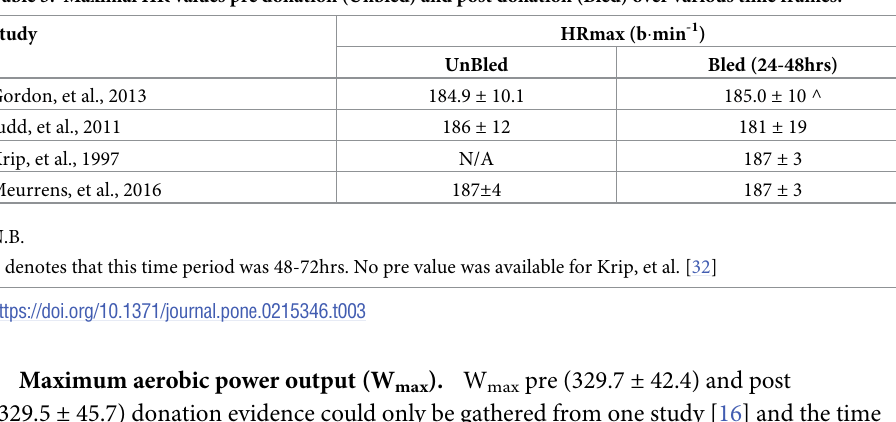
Fig 2. Statistical results from four studies of pre and 24–48 hr post BD in _ VO the effect size of the studies. The white diamond shows the overall mean effect size. All effect sizes are Cohen’s d and 95% confidence interval, with heterogeneity of I 2 = 0%. https://doi.org/10.1371/journal.pone.0215346.g002 Table 3. Maximal HR values pre donation (Unbled) and post donation (Bled) over various time frames.